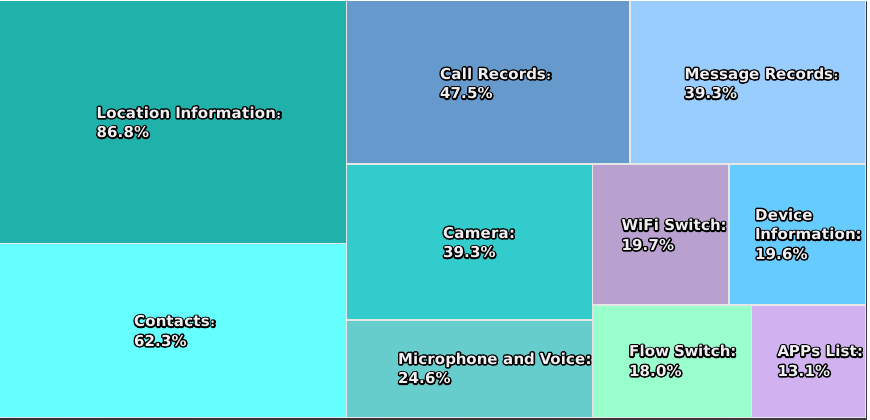
Figure 1. Permissions to install and use mobile